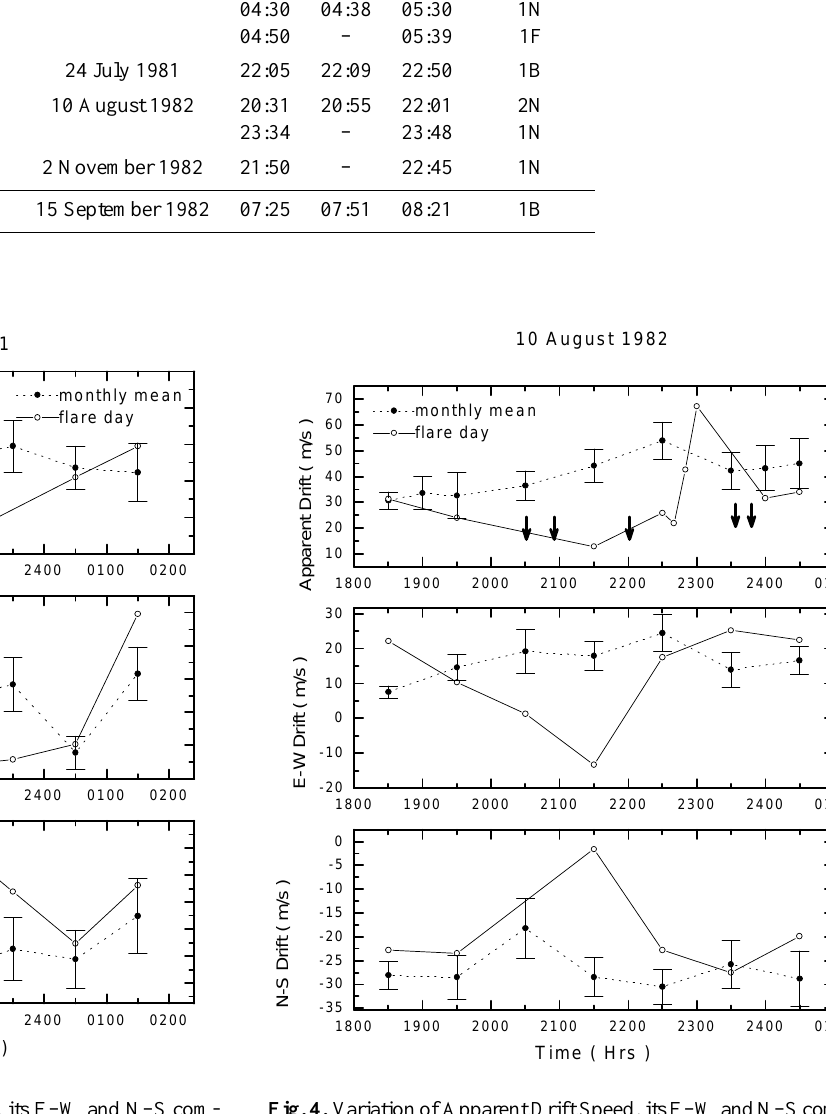
Fig. 3. Variation of Apparent Drift Speed, its E–W and N–S com- ponents on 24 July 1981, along with their respective monthly mean variation. Solar flare occurred at 22:05, 22:09 and 22:50 (1B). The rest of the details are the same as in Fig. 1.